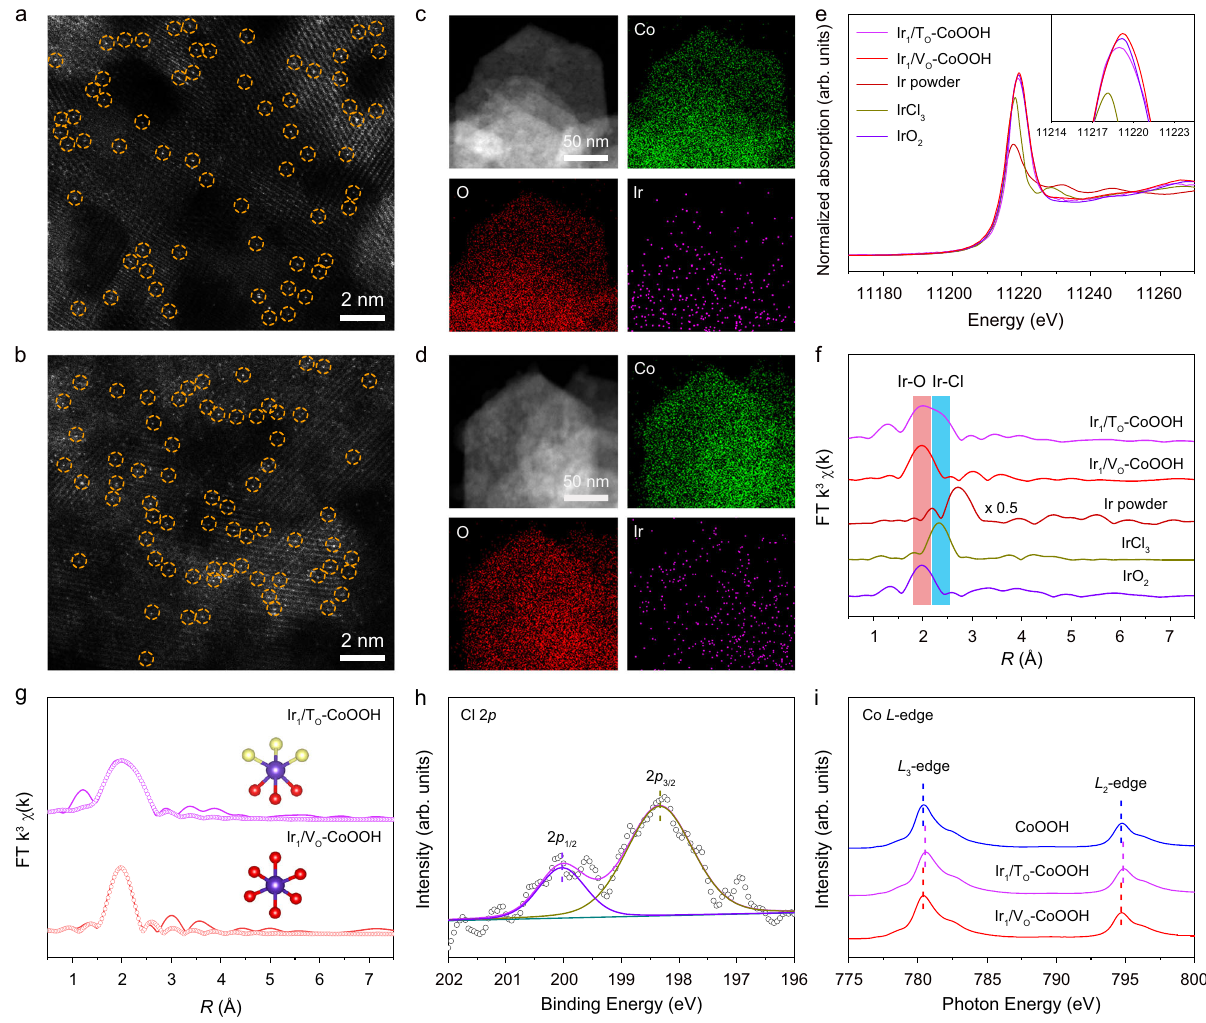
Fig. 2 Structural characterizations of Ir single atoms on CoOOH nanosheets. a , b HAADF-STEM images of Ir 1 /T O – CoOOH ( a ) and Ir 1 /V O – CoOOH ( b ). Singly-dispersed Ir atoms are indicated by yellow circles. c , d EDX elemental mapping of Ir 1 /T O – CoOOH ( c ) and Ir 1 /V O – CoOOH ( d ). e , f Normalized XANES ( e ) and EXAFS ( f ) spectra at the Ir L 3 -edge for Ir 1 /T O – CoOOH and Ir 1 /V O – CoOOH. Ir powder, IrCl 3 , and IrO 2 were used as references. g Experimental and fi tting EXAFS results of Ir 1 /T O – CoOOH and Ir 1 /V O – CoOOH. The experimental and fi tting results are shown in solid lines and circles, respectively. The inset atomic models are the fi rst-shell coordination of Ir. The red, yellow, and purple spheres represent O, Cl, and Ir atoms, respectively. h Cl 2 p XPS spectrum of Ir 1 /T O – CoOOH. i Co L -edge XAS spectra of CoOOH, Ir 1 /T O – CoOOH, and Ir 1 /V O –